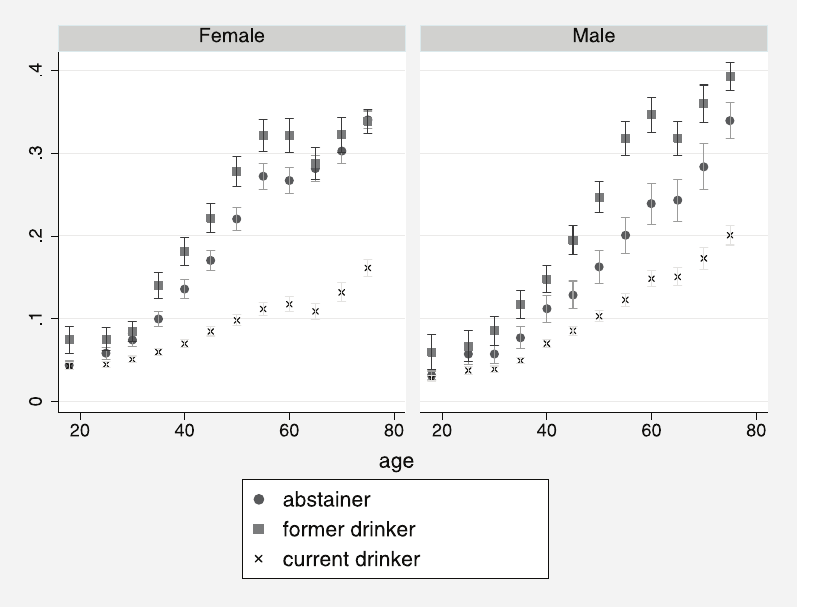
Figure 2. Prevalence of fair/poor health byage, gender and drinking status: Abstainers vs. formerdrinkers vs. current drinkers (spike with caps: 95%confidence interval).